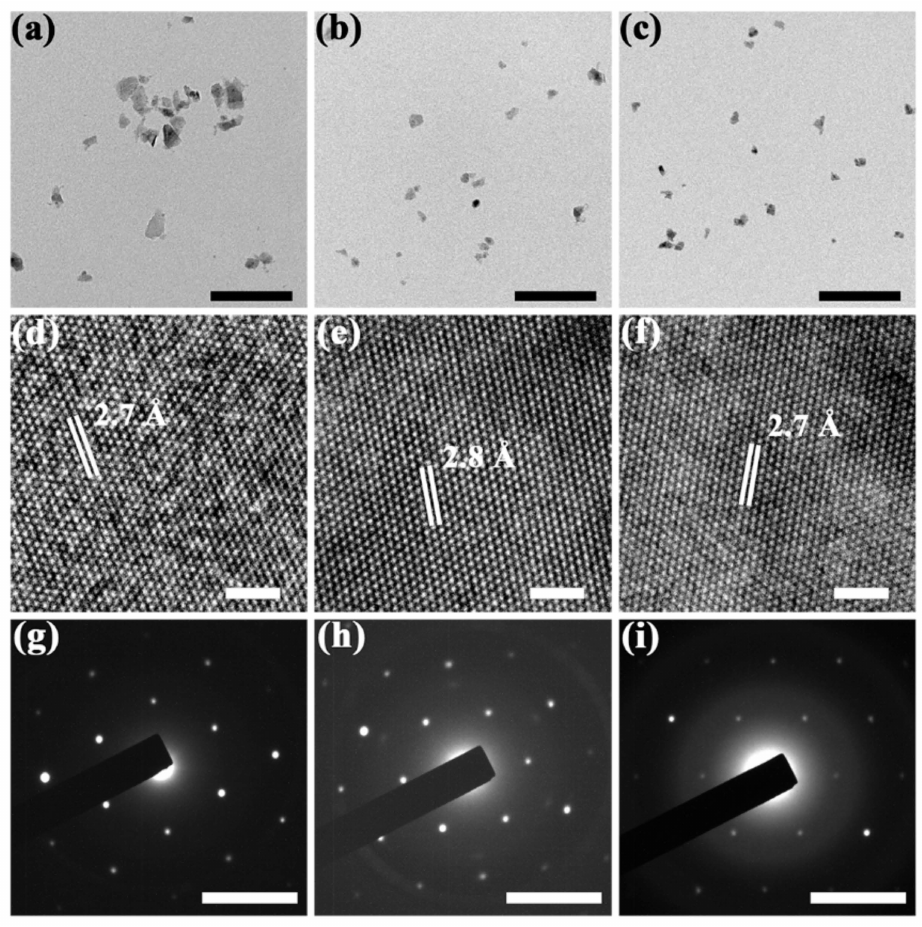
Figure 4. ( a – c ) TEM, ( d – f ) HRTEM, and ( g – i ) SAED images of MoS 2 , MoSe 2 , and WS 2 NSs prepared by CMC–assisted ball milling: MoS 2 ( a , d , g ), MoSe 2 ( b , e , h ), and WS 2 ( e , f , i ). Scale bars: 200 nm for